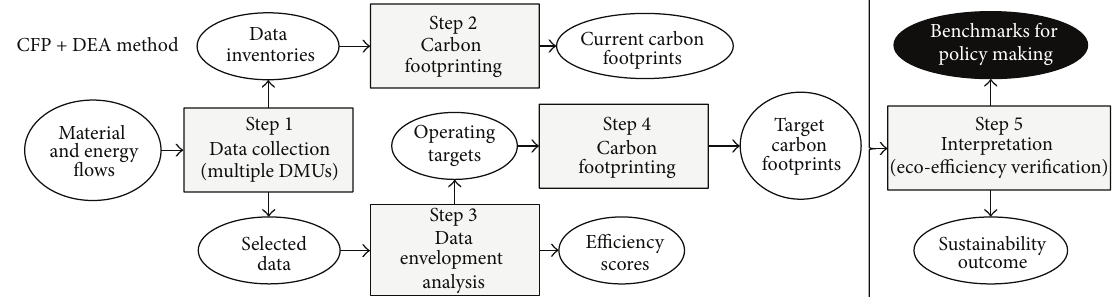
Figure 2: The five-step CFP + DEA